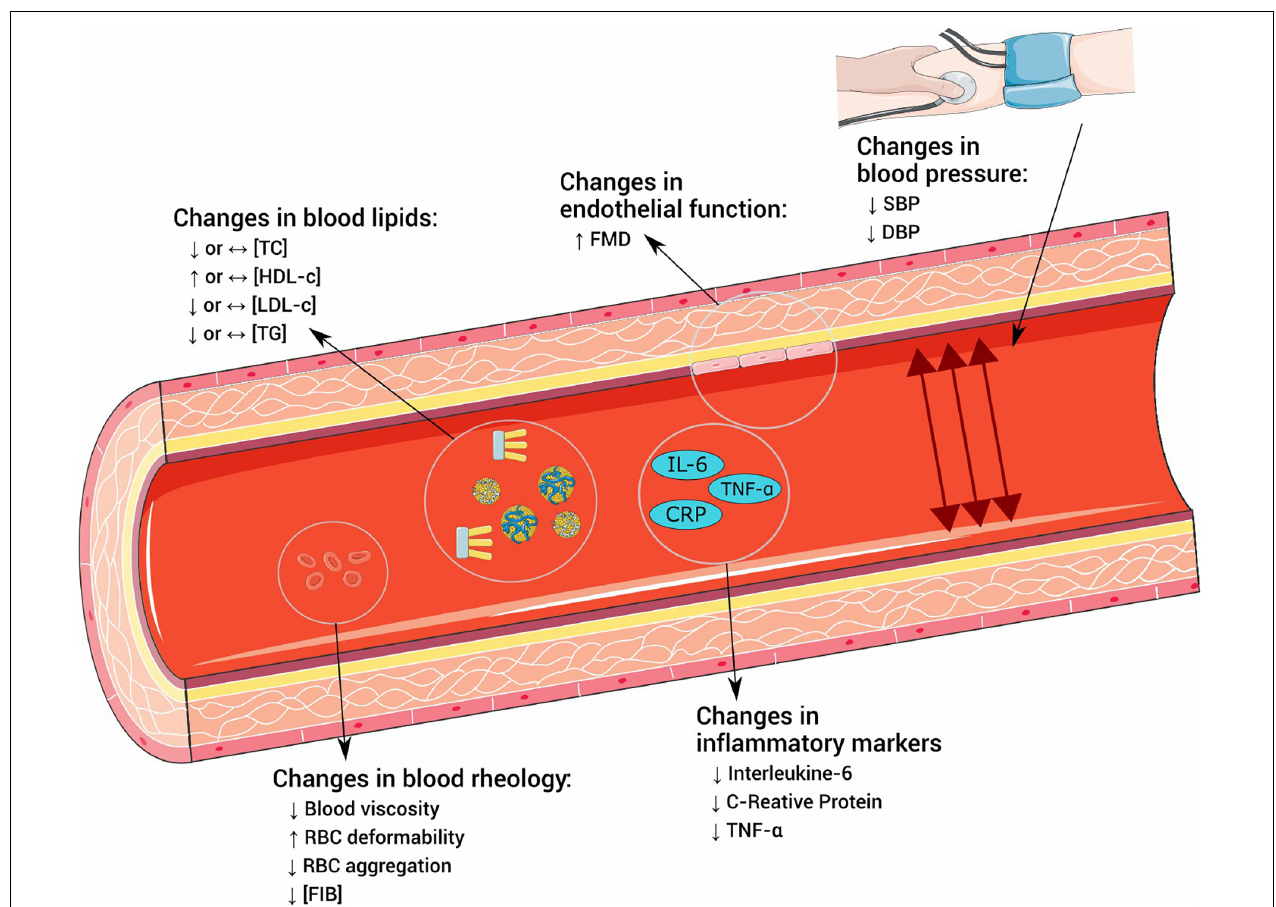
FIGURE 1 | Effects of exercise in risk factors for atherosclerosis. TC, total cholesterol; HDL-c, high-density lipoprotein cholesterol; LDL-c, low-density lipoprotein cholesterol; TG, triglycerides; FMD, flow-mediated dilatation; SBP, systolic blood pressure; DBP, diastolic blood pressure; RBC, red blood cell; FIB, fibrinogen; IL-6, interleukin 6; CRP, C-reactive protein; TNF- α , tumoral necrosis factor α